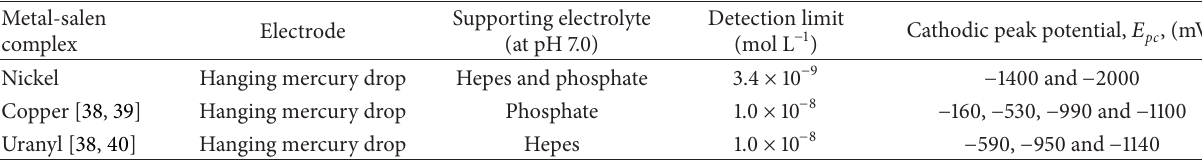
(II)-salen complexes in an aqueous medium. 2